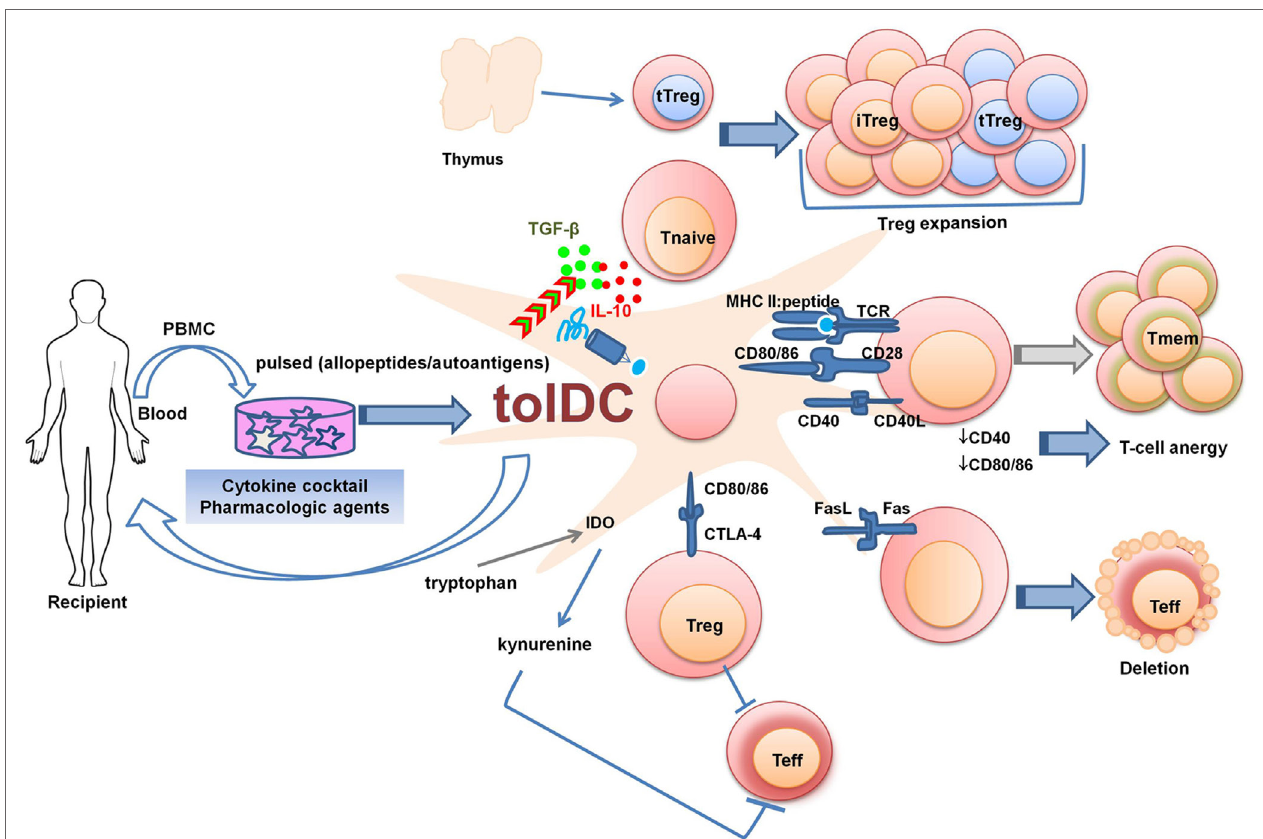
FiGURe 1 | Strategies to generate tolDCs for clinical therapeutics. PBMCs or bone marrow-derived cells can be differentiated into tolDCs in the presence of pharmacologic agents and immunomodulatory cytokines. The generated tolDCs are either donor-derived (in the case of living-donor transplantation) or autologous (in the case of autoimmune diseases or transplantation) and can be further pulsed in vitro with specific antigens (peptides, donor cell lysates, apoptotic cells). tolDCs can regulate Teff responses by various mechanisms: 1. Fas/FasL pathway-mediated deletion; 2. Production of IDO which degrades the essential amino acid tryptophan through kynurenine pathway, causing starvation of Teff. The production of IDO is favored by reversed signaling via interaction between CD80/CD86 on DCs and CTLA-4 on regulatory T cell (Treg). 3. Surface expression of inhibitory molecules and secretion of regulatory mediators. Abbreviations: CTLA-4, cytotoxic T-lymphocyte antigen-4; IDO, indoleamine 2,3-dioxygenase; iTreg, induced regulatory T cell; PBMC, peripheral blood mononuclear cells; tolDC, tolerogenic dendritic cell; Teff, effector T cell; Tmem, memory T cell; Tnaive, naïve T cell; tTreg, thymic-derived regulatory T